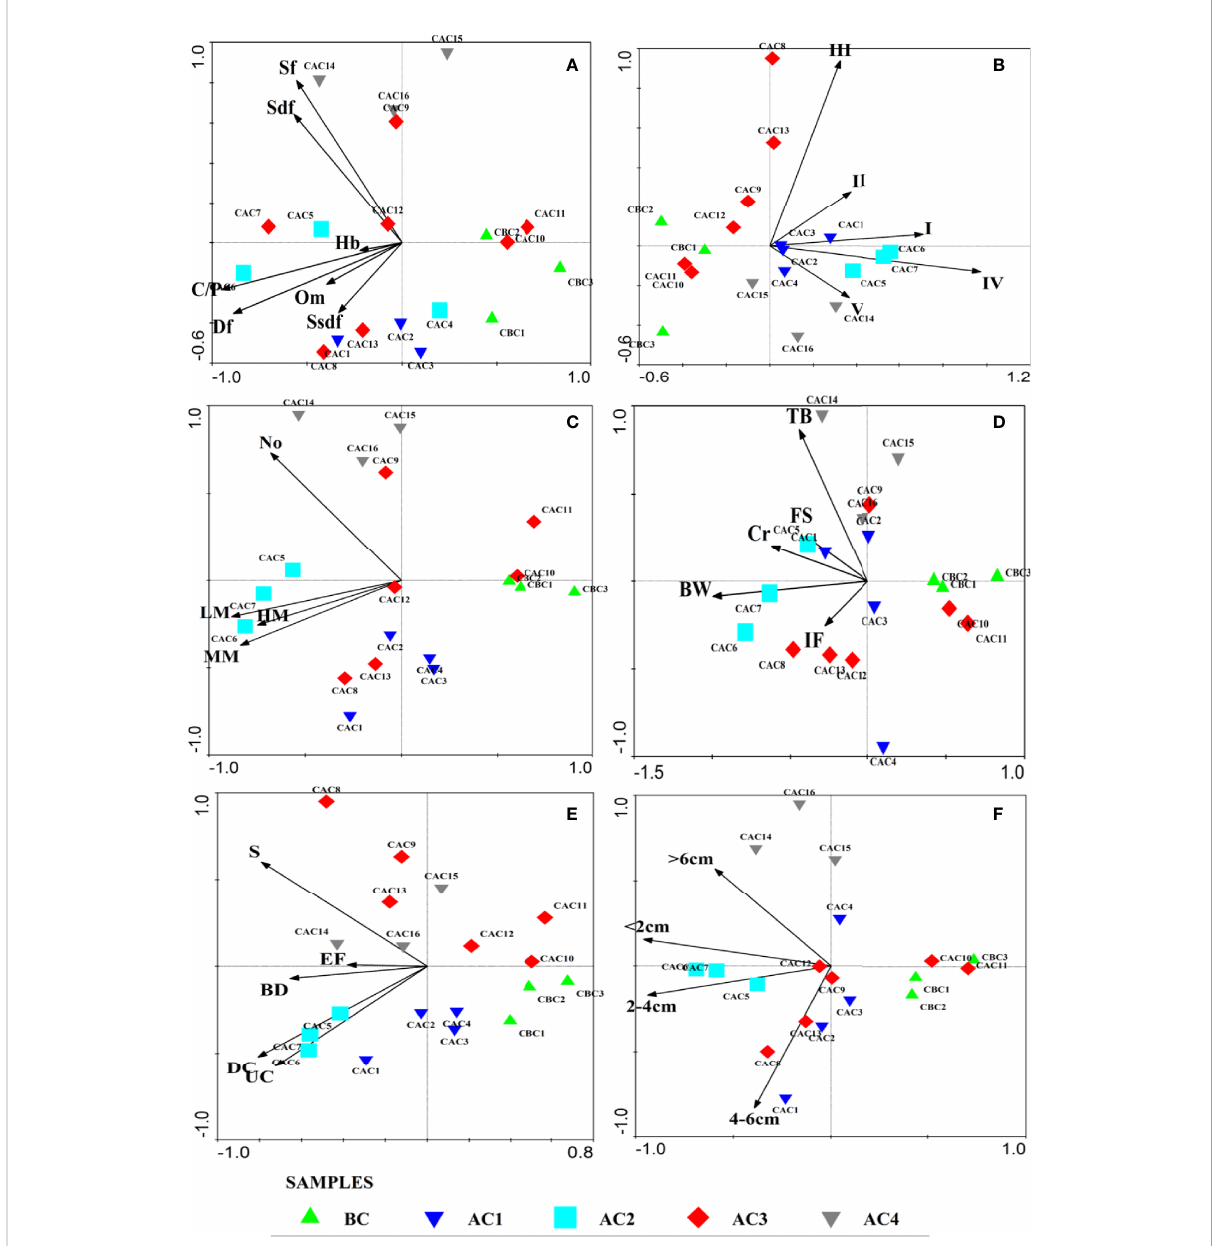
FIGURE 2 PCA bi-plot of different traits. (A) Feeding trait, (B) ecological groups, (C) locomotion, (D) habitat, (E) bioturbation, and (F) size. BC, before cyclone; AC1, after cyclone phase 1; AC2, after cyclone phase 2; AC3, after cyclone phase 3; AC4, after cyclone phase